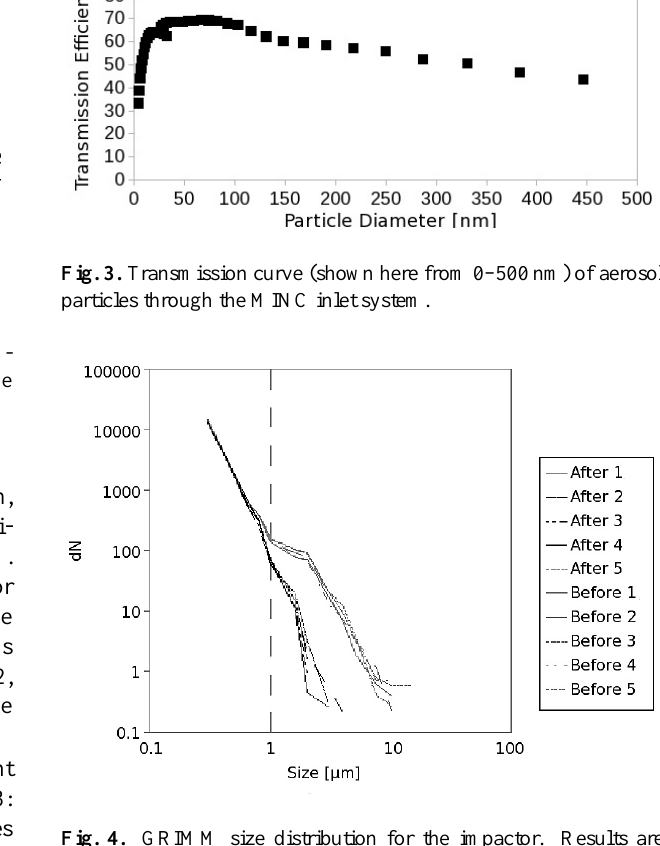
Fig. 4. GRIMM size distribution for the impactor. Results are shown for before and after the inlet system as denoted by the figure